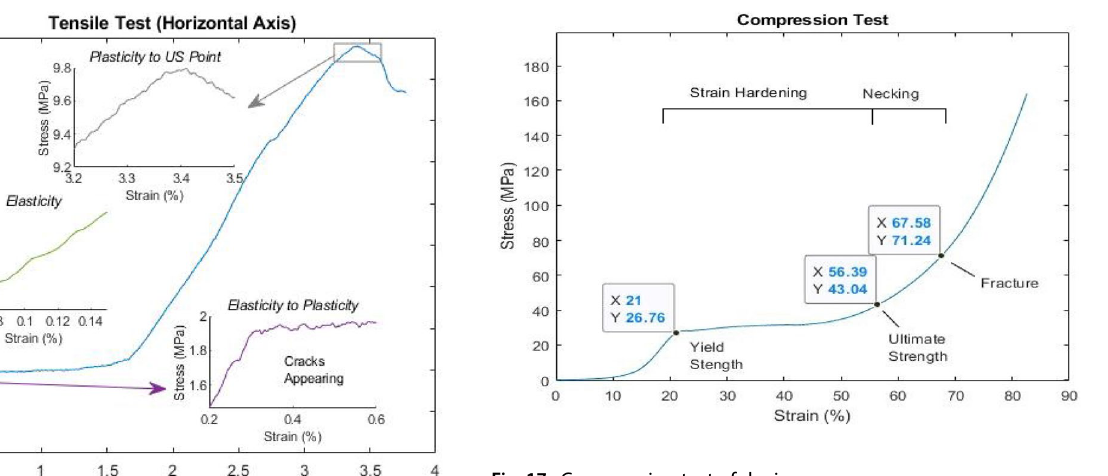
Fig. 17 Compression test of device